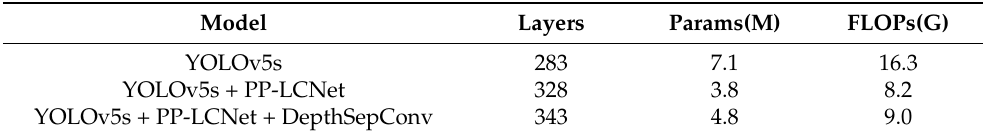
Table 1. Comparison of number of layers, parameters, and calculation in the YOLOv5s improve- ment